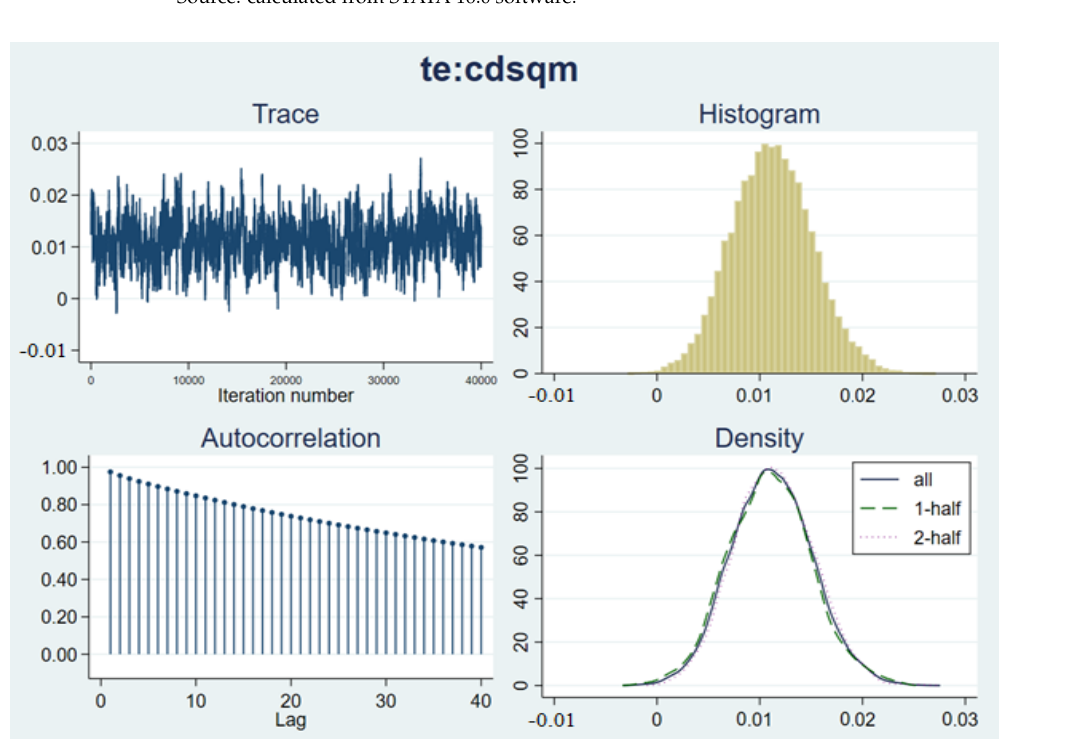
Figure 3. The result of testing the convergence of the MCMC chain corresponding to the regression coefficient of digital transformation by scale variable (CDS*QM) . Source: calculated from STATA 16.0